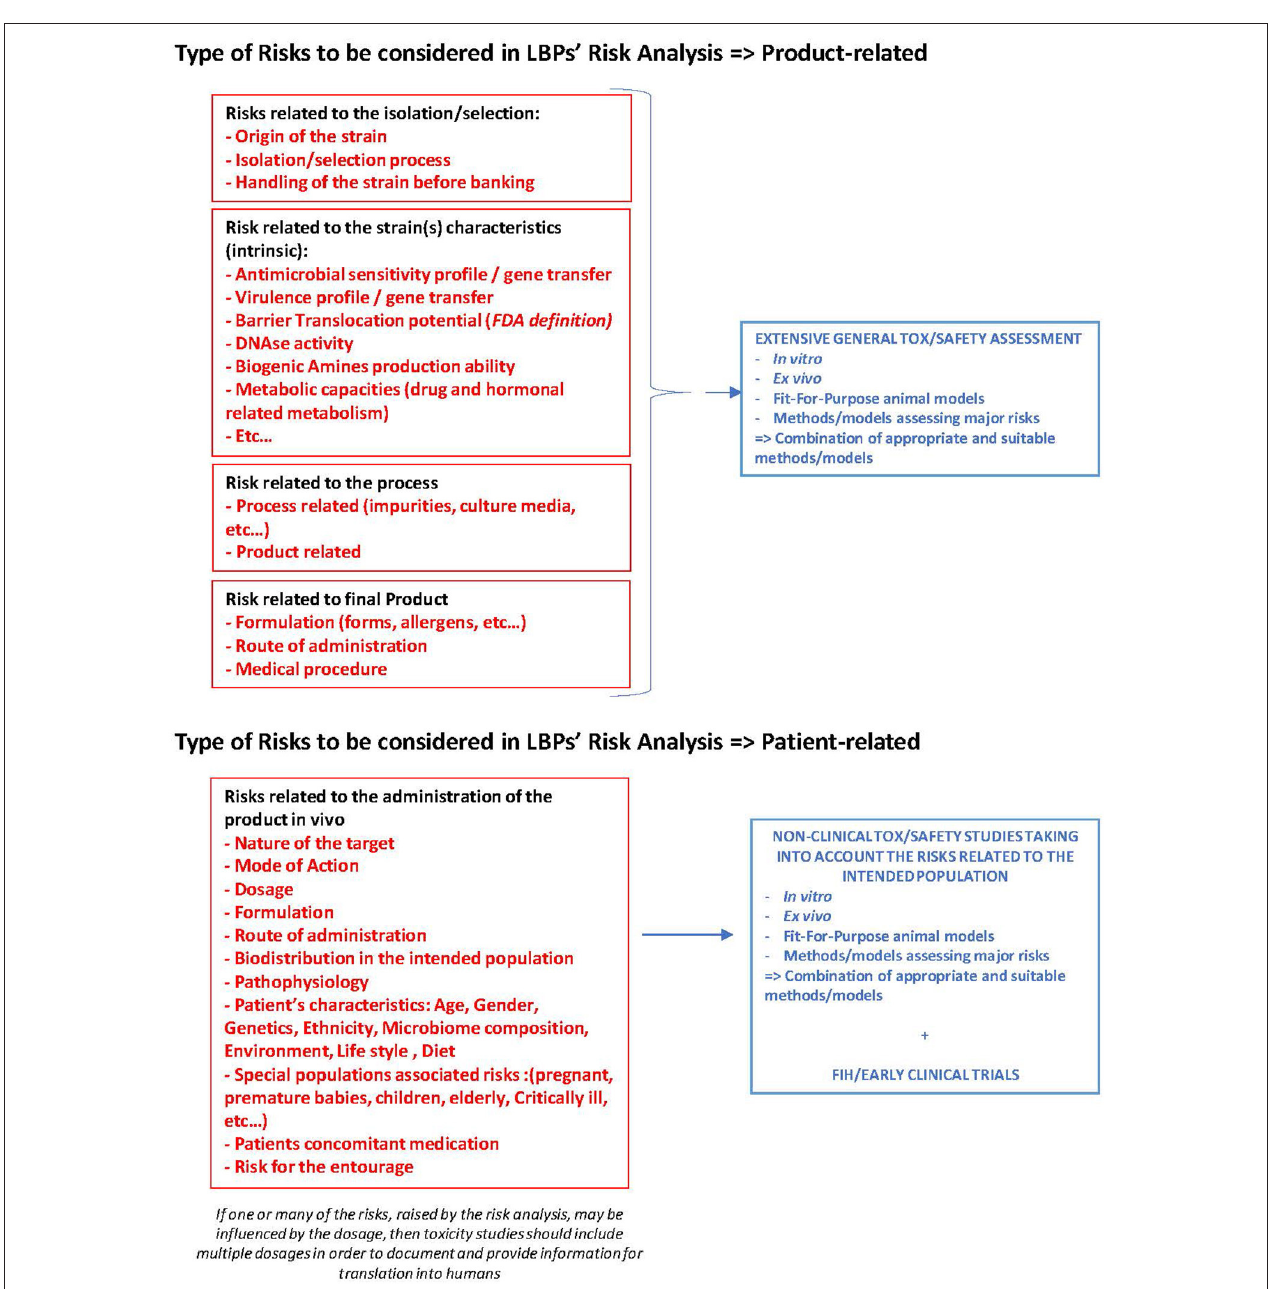
FIGURE 1 | Road map for LBP’s risk analysis. Different types of risks to be considered in LBP development and to be documented at the non-clinical and clinical stage.